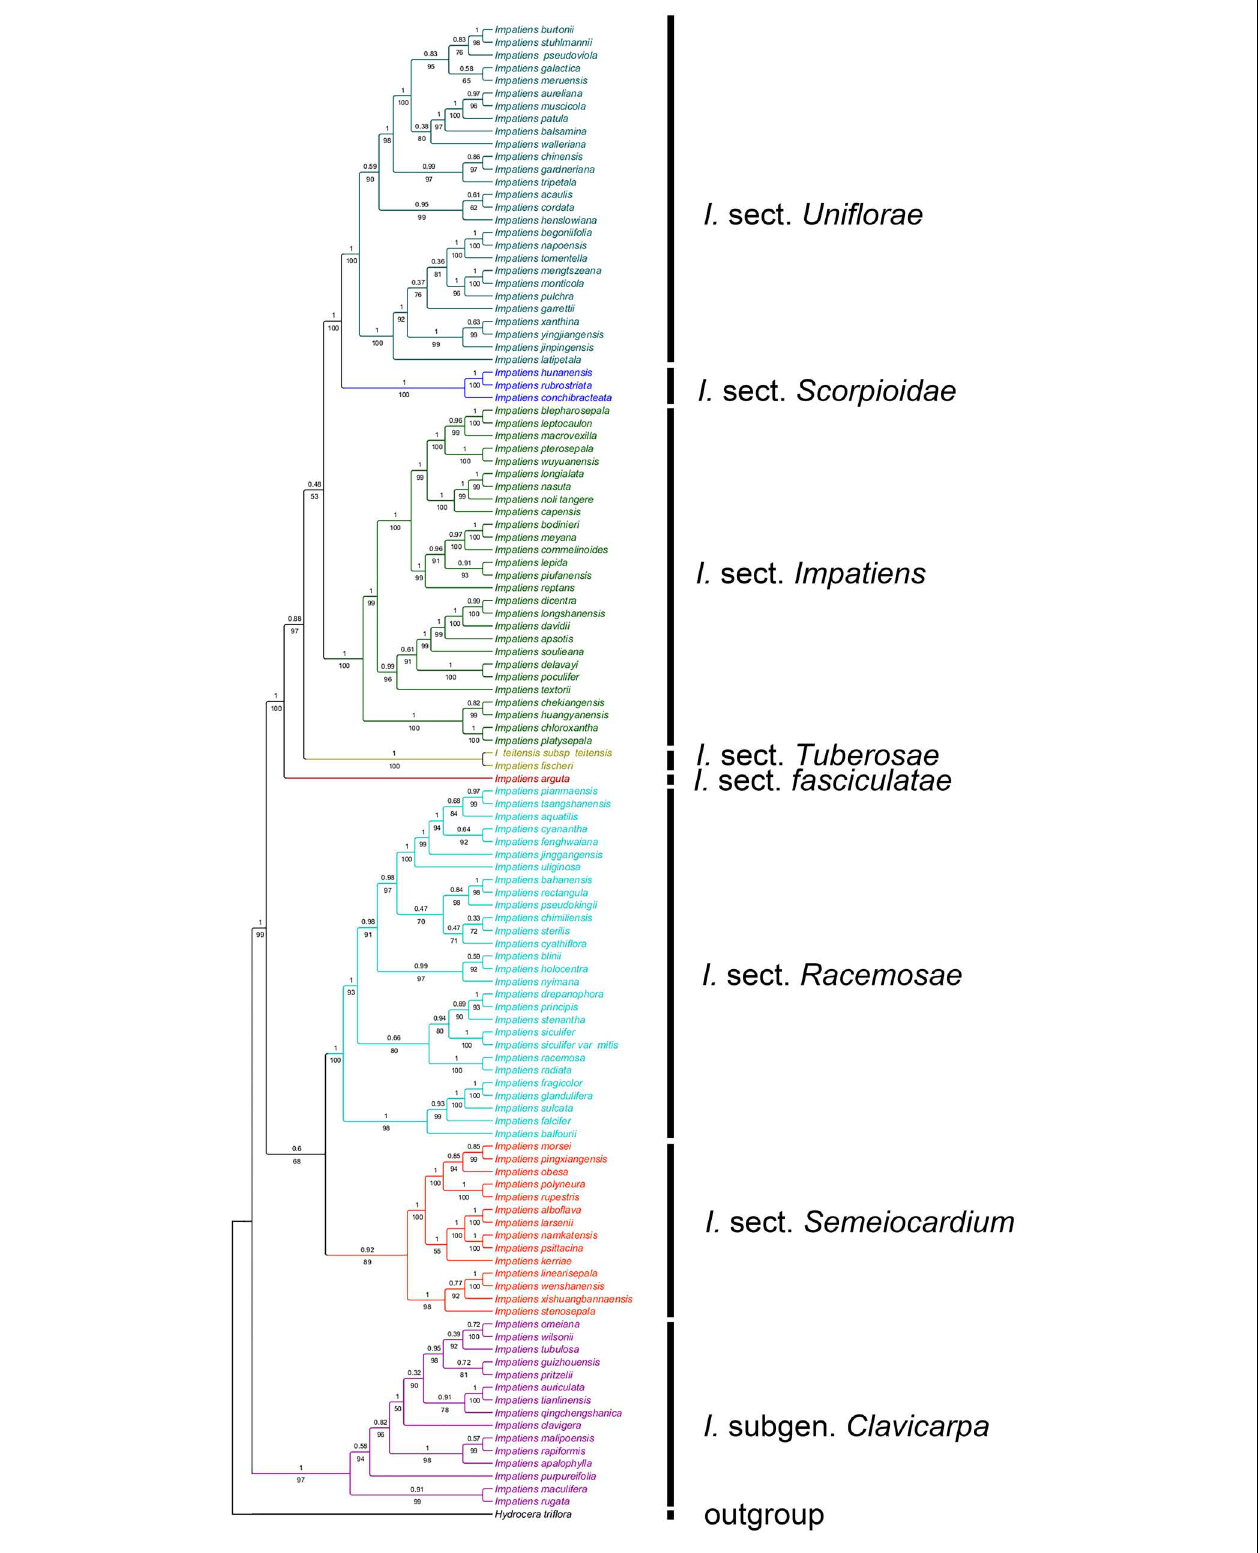
FIGURE 2 | The phylogenetic tree inferred from maximum likelihood (ML) and Bayesian based on a combined dataset of ITS and atpB-rbcL sequences. Values below the branches are maximum likelihood bootstrap supports, and above the branches are Bayesian posterior probabilities.